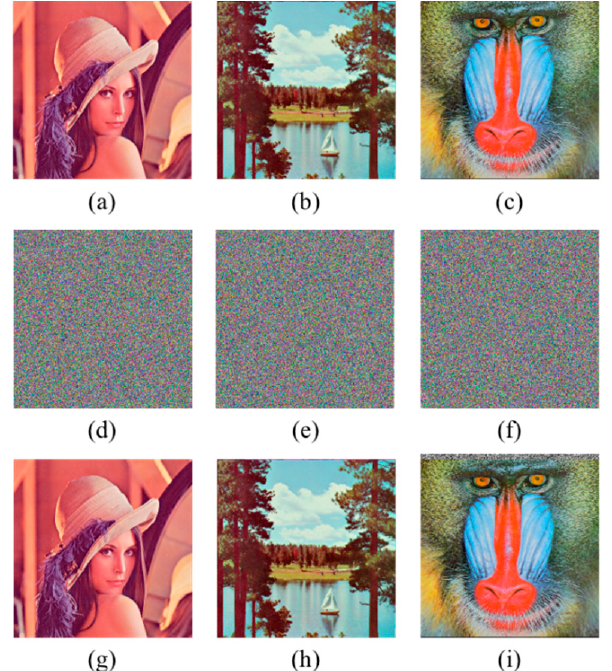
Figure 18. Encryption and decryption of color images. ( a – c ) are all kinds of color images, ( d – f ) are corresponding encrypted images, ( g – i ) are corresponding decrypted images.